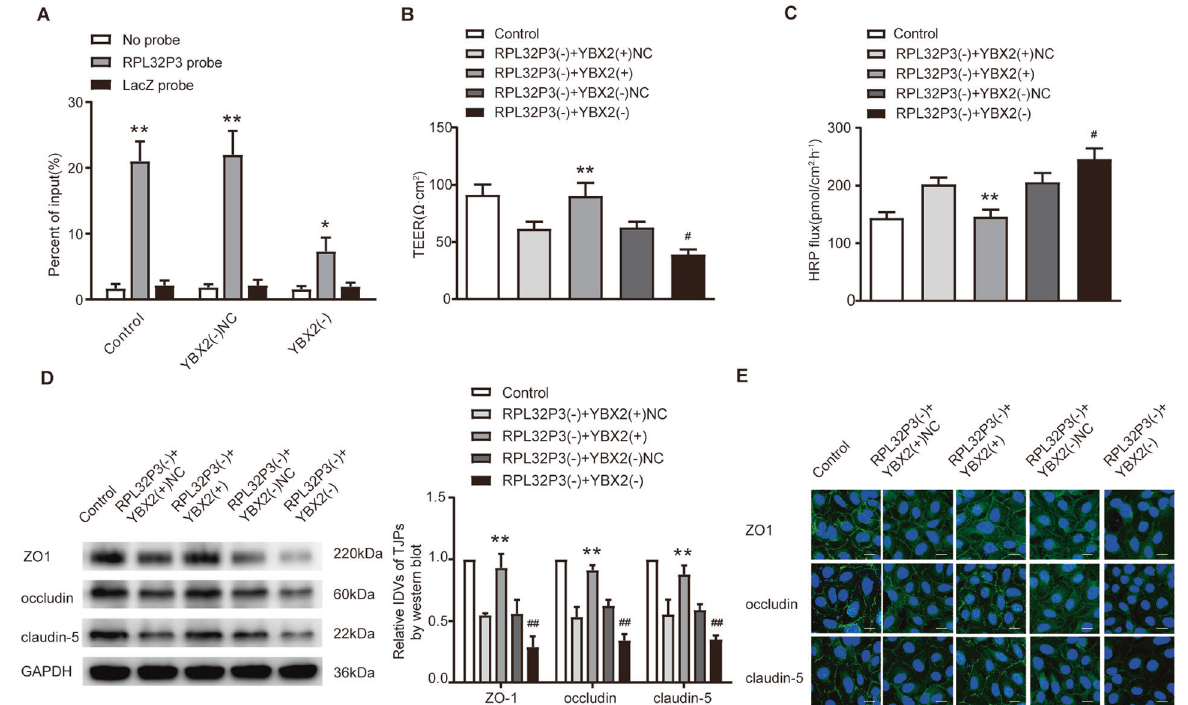
Fig. 4 YBX2 participated in the process of RPL32P3 regulating BTB permeability. A Chromatin isolation by RNA puri fi cation (ChIRP) assays showed that RPL32P3 had a signi fi cant occupancy on the YBX2 promoter. The bound DNA was detected by qRT-PCR with speci fi c primers against the YBX2 promoter. Data represent mean ± SD ( n = 3, each group). * p < 0.05 vs. LacZ probe, ** p < 0.01 vs. LacZ probe. B , C Effects of RPL32P3 and YBX2 on TEER value and HRP fl ux. ** p < 0.01 vs. RPL32P3(-) + YBX2( + )NC group, # P < 0.05 vs. RPL32P3(-) + YBX2 (-)NC group. D Effects of RPL32P3 and YBX2 on the expression levels of ZO-1, occludin and claudin-5 determined by western blot. Data represent mean ± SD ( n = 3, each group). ** p < 0.01 vs. RPL32P3(-) + YBX2( + )NC group, ## p < 0.01 vs. RPL32P3(-) + YBX2(-)NC group. E Effects of RPL32P3 and YBX2 on ZO-1, occludin and claudin-5 expression levels and distribution determined by immuno fl uorescence. Scale bar represents 30 μ H3K4me3 antibody relative to its corresponding input (Fig. 3H, I). The results showed that both PCR1 and PCR4 products decreased signi fi cantly after RPL32P3 knockdown.